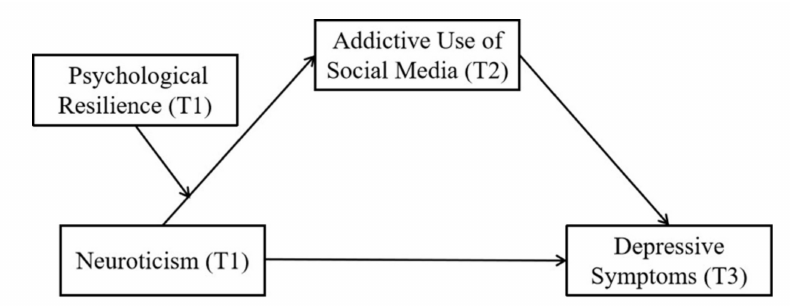
Figure 1. Moderated mediation model of the present